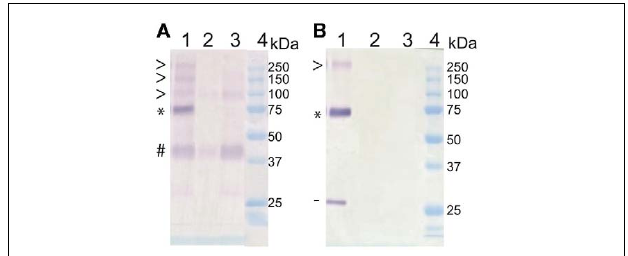
FIGURE 2 |Western blot analysis of PHT1;1, PHT1;2, and PHT1;3 on root membrane protein extracts reveal the presence of potential multimers. Plants were grown in vitro on medium supplemented with high (500 μ M) or low (10 μ M) Pi content ( + P or − P respectively). Five micrograms of membrane protein were loaded per lane, on 10% acrylamide SDS PAGE gels before protein transfer onto nitrocellulose membranes. (A) The primary antibody was designed against two peptides common to PHT1;1, PHT1;2, and PHT1;3. In parallel, an anti GFP antibody (Roche) was used for control western blots at the same dilution (B) . Lanes were loaded as follows: (1)Transgenic line expressing 35S:PHT1;1:GFP construct; and wild type control on + P (2) or − P (3) and Bio-Rad Precision Plus Protein Standards (4). GFP tagged ( ∗ ) and untagged (#) PHT1 monomeric form, putative multimers ( > ) and cleaved GFP ( −